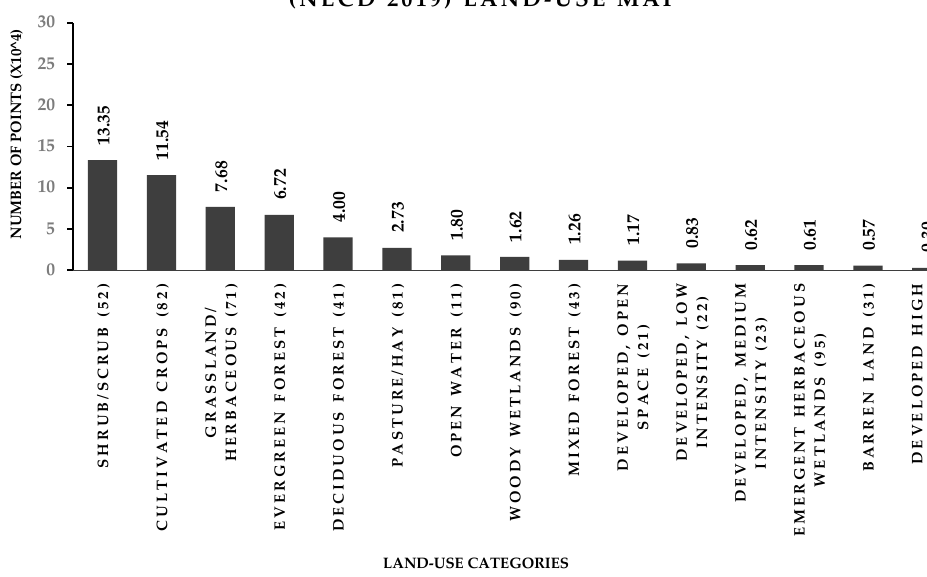
Figure 5. Frequency analysis for the extracted samples from the NLCD 2019 dataset.